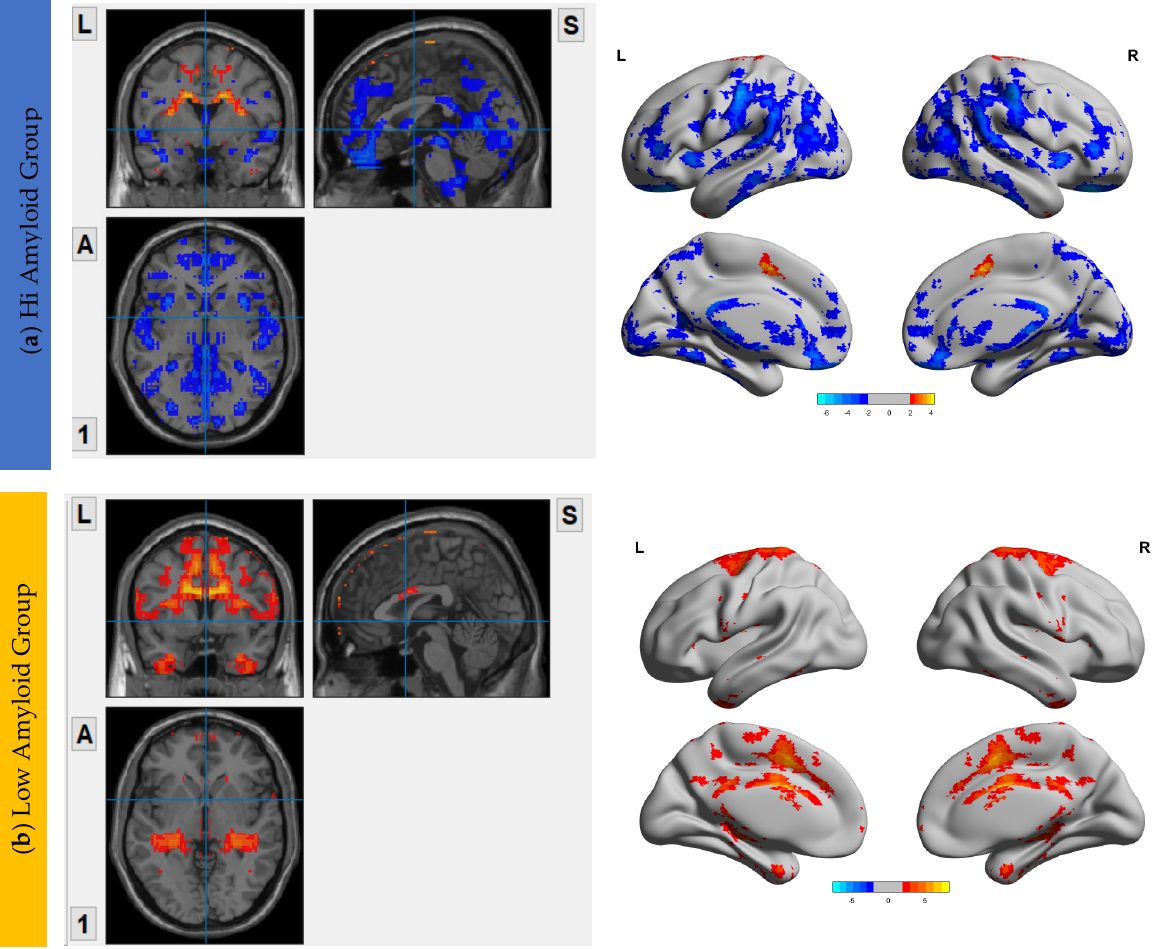
Figure 2. VMHC Maps showing interhemispheric functional connectivity (IFC) of HiAmy and LowAmy groups when compared to HC. ( a) showed Voxel-wise two-sample t-tests of VMHC maps from HiAmy when compared to HC. ( b) showed Voxel-wise two-sample t-tests of VMHC maps from LowAmy when compared to HC. All comparisons were adjusted for age, sex, and total intracranial volume, with Gaussian random field correction. The significance threshold at the voxel level was set at p < 0.01; and at cluster level was set at p < 0.05. The blue and red colors illustrate significant t values according to the scale on the right. VMHC: Voxel Mirrored Homotopic Connectivity. HC: Health Control. HiAmy: Patient group with global SUVr > 0.62. LowAmy: Patient group with global SUVc < 0.62.